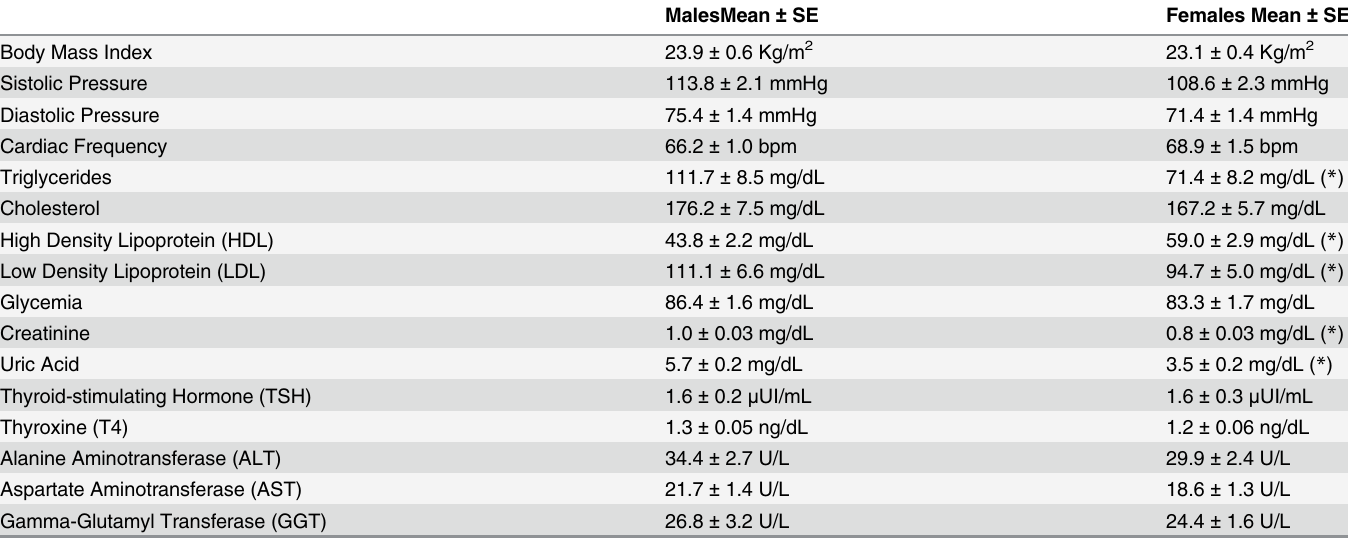
Table 1. Clinical and Laboratory information of the subjects.